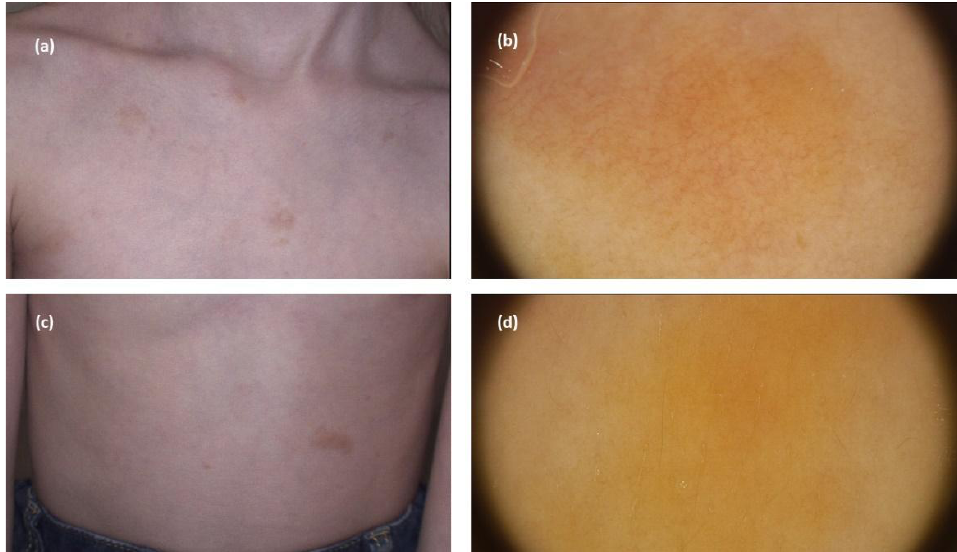
Figure 5. ( a , c ) Maculopapular cutaneous mastocytosis (plaque-type mastocytosis clinical subtype) — clinical presentation. ( b ) Dermoscopy shows reticular vascular pattern (thin reticular telangiectasias) over yellow background. ( d ) Dermoscopy shows yellow structureless areas (FotoFinder, Medicam 800 HD, FotoFinder Systems GmbH, Bad Birnbach, Germany; ×20 magnification, immersion gel).